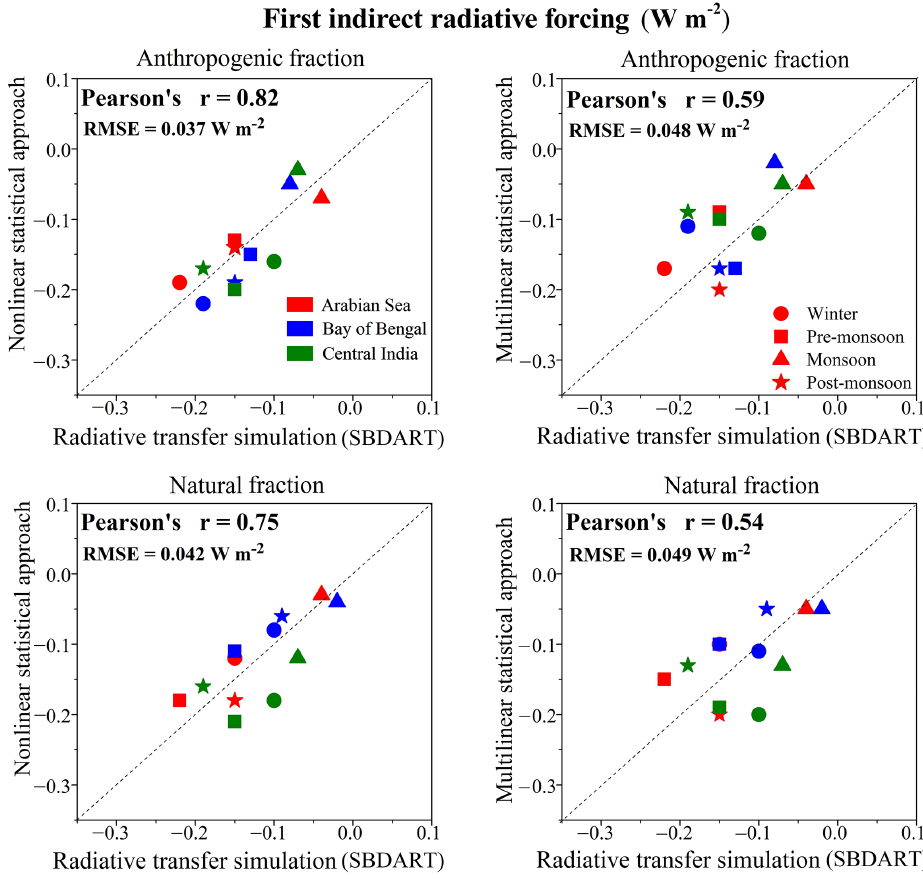
Figure 3. Comparison between satellite-based RF aci using both statistical fits and the one simulated by the SBDART model for all three regions and for all seasons. The different colours indicate the regions, whereas the different symbols indicate the different seasons. Note that the fit is separately performed for each season and each